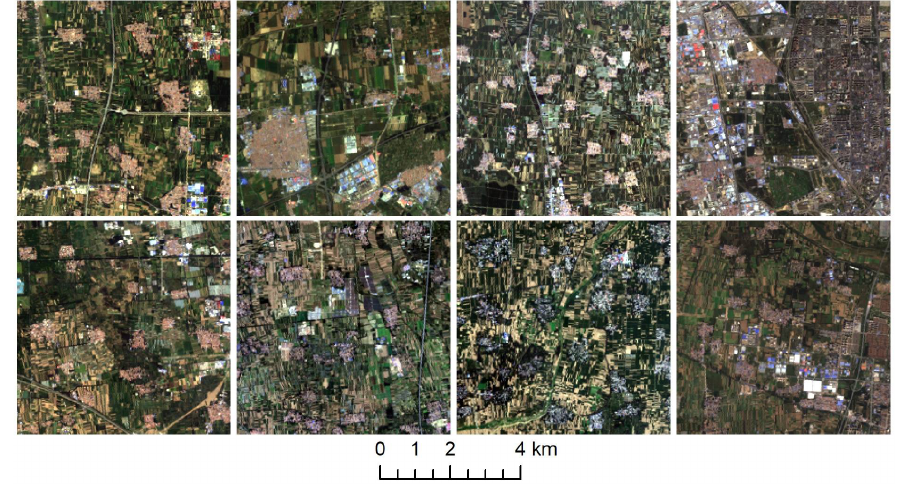
Figure 8. Examples of clear blocks sampled from Landsat 8 OLI data (path: 123, row: 32, acquired date: 23 September 2015).